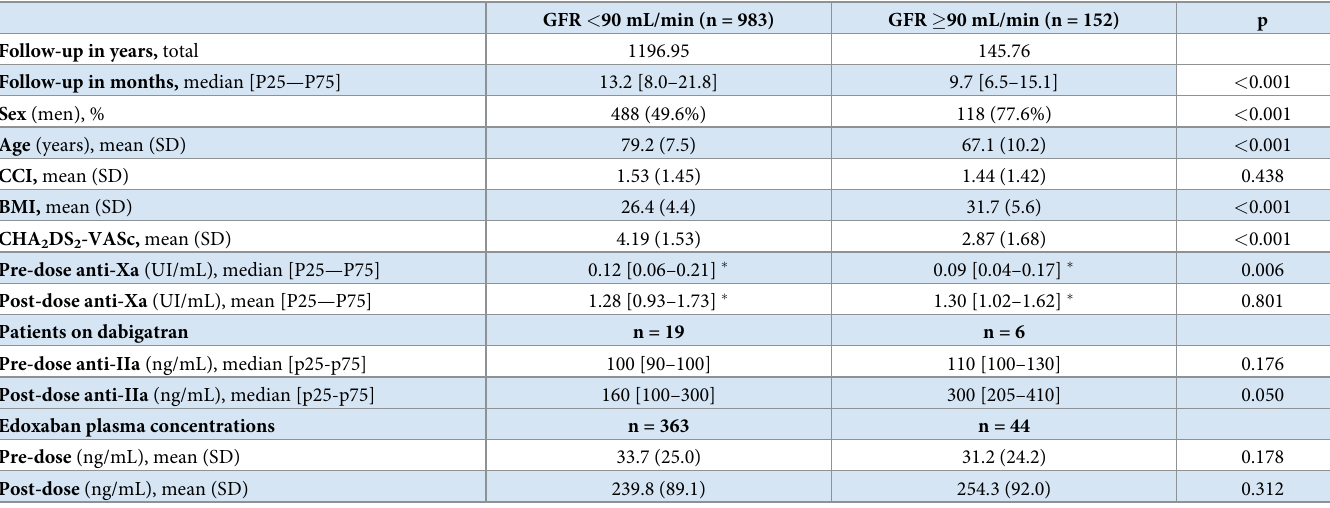
Table 1. Patient baseline characteristics by GFR.